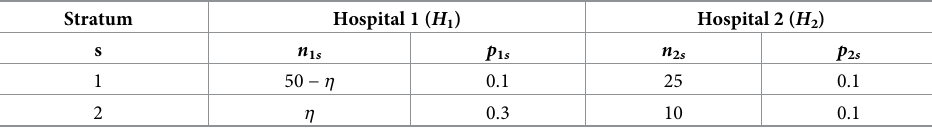
Table 5. Example of variations in case mix under internal standardization: Parameter values.